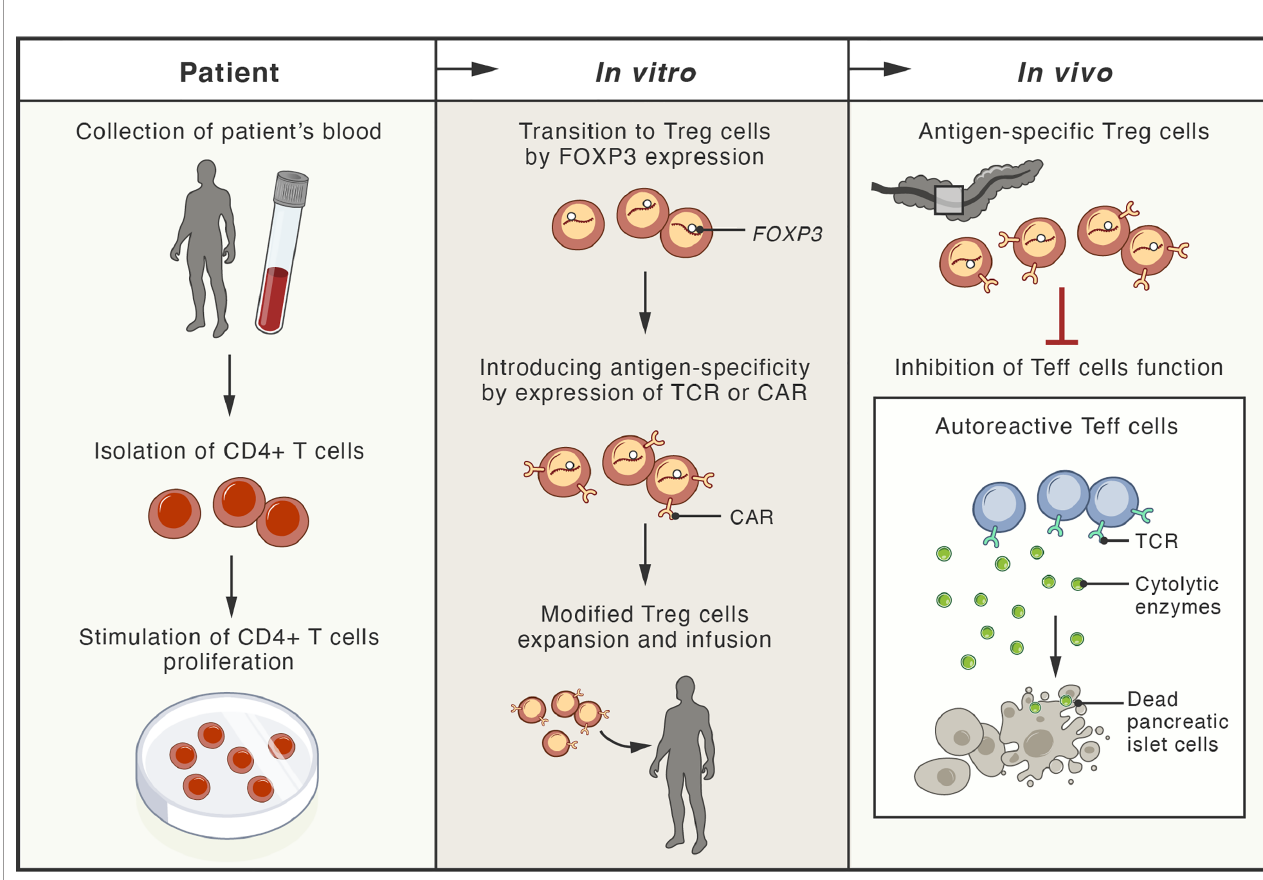
FIGURE 3 | Schema of possible therapeutic approaches with adoptive cell therapies involving genetically modi fi ed regulatory T cells. The blood of patient with type 1 diabetes mellitus (T1DM) is used for isolation of CD4 + T cells. These cells, expanded in vitro , undergo transition to regulatory T cells (T reg ) by genetic modi fi cation, leading to stable expression of the FOXP3 protein (master transcription factor of T reg cells). These cells are further modi fi ed by the expression of antigen-speci fi c T- cell receptor (TCR) or chimeric antigen receptor (CAR). Upon infusion, the genetically modi fi ed T reg cells localize to the pancreas of the patient, where they inhibit the cytotoxic function of effector T cells (T eff ), responsible for destruction of pancreatic islet